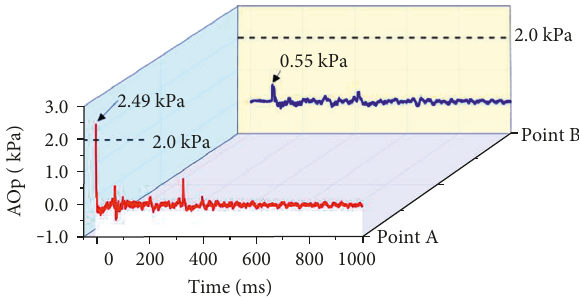
Figure 12: AOp time histories with working